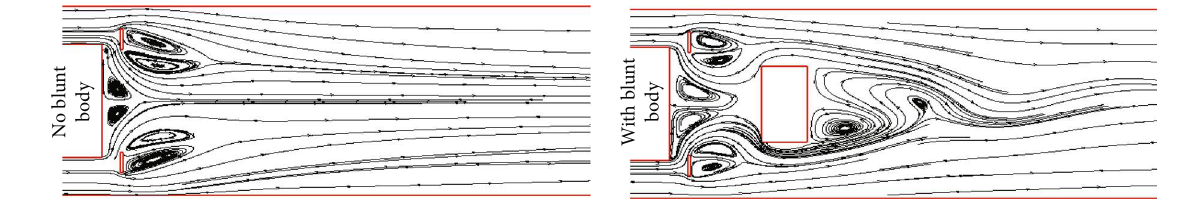
Figure 15: Flow fi eld distribution with or without the blunt